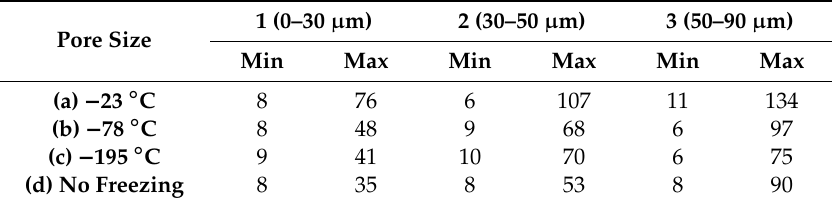
Table 2. Evaluation of the pore sizes in hydrogels prepared under di ff erent freezing conditions and with various porogen fractions. Minimum and maximum pore sizes found in SEM (a–c)) and LSCM (d)